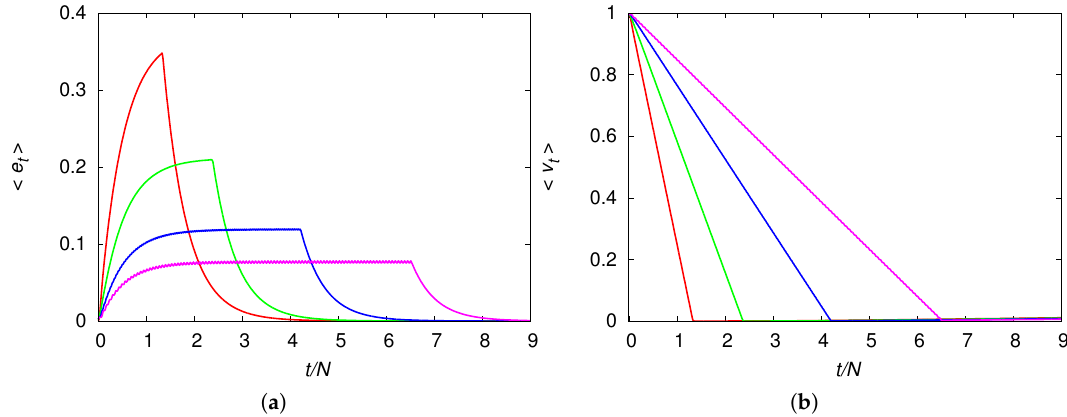
Figure 6. ( a ) Mean engineer density (cid:104) e t (cid:105) as function of the rescaled time t / N ; ( b ) Mean fraction of virgin habitats (cid:104) v t (cid:105) as function of the rescaled time t / N . The dispersal probability is µ = 0.9 (red line), µ = 0.1 (green line), µ = 0.01 (blue line) and µ = 0.001 (magenta line) and the other model parameters are r = 1, α = 1, δ = 0.01, ρ = 10 − 5 . The chain size is N = 201 and the fixed point solution is e ∗ ≈ 0.001 and v ∗ ≈